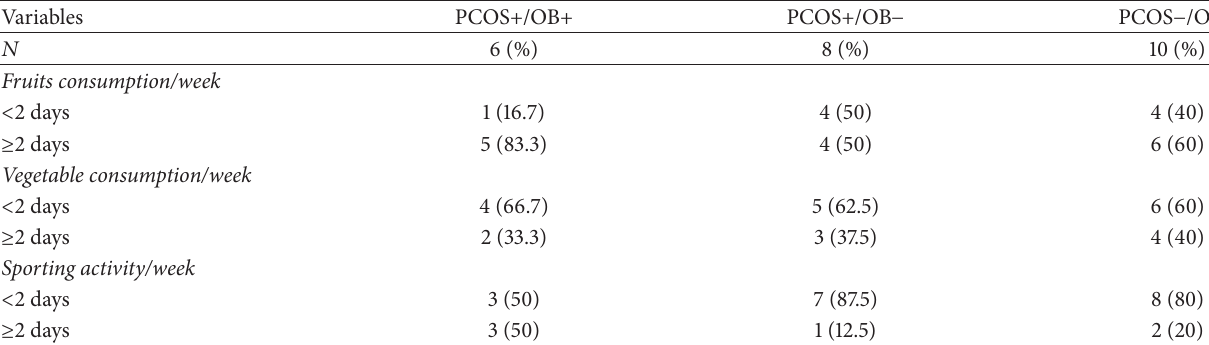
Table 2: Lifestyle habits of our study